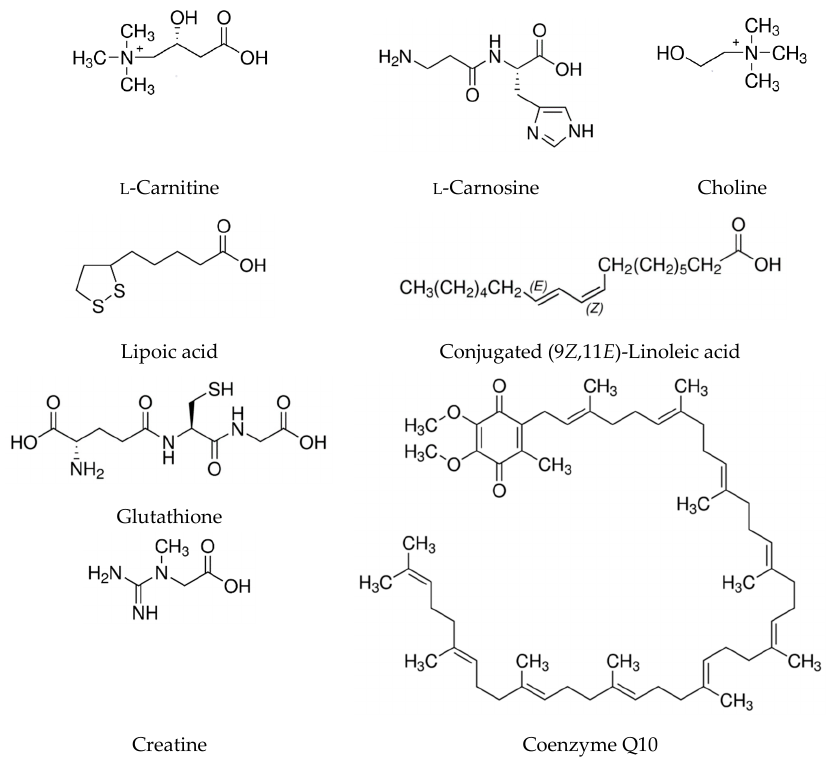
Figure 1. Chemical structures of selected bioactive compounds found in meat and its